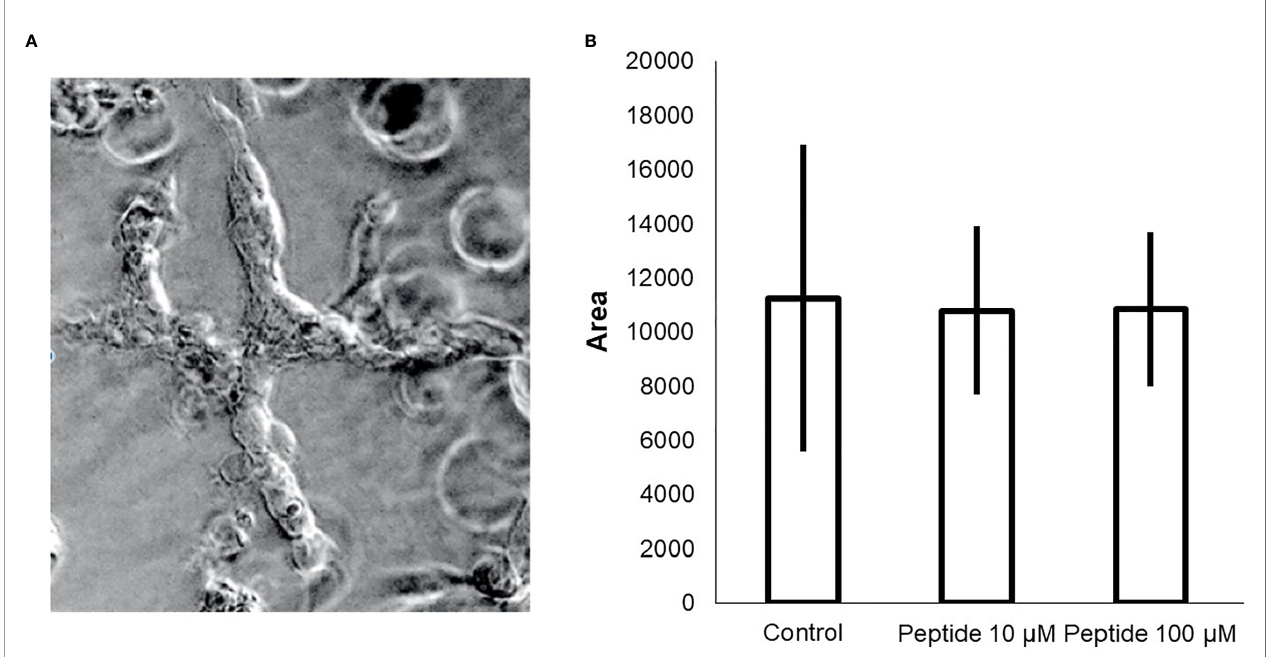
FIGURE 7 | Effect of HS-binding peptide in the 3D culture (spheroid) triple-negative breast cancer. Patient-derived xenotransplant cells (PDX cells) were obtained from tissue collected of a triple negative breast cancer patient. (A) The cells cultured for 14 days. The exchange of culture medium was performed every three days. (B) Cell proliferation and viability analysis were determined by the size of the colonies (area). Measurements were obtained using a Nikon microscope using 10X magni fi cation (Nikon, Minato, Tokyo, Japan). The assay was performed in triplicate. Peptide did not affect triple-negative cells, p>0.05